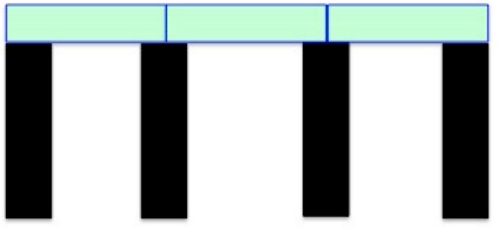
Figure 15. Simple diagram for the three-span bridge with piers.